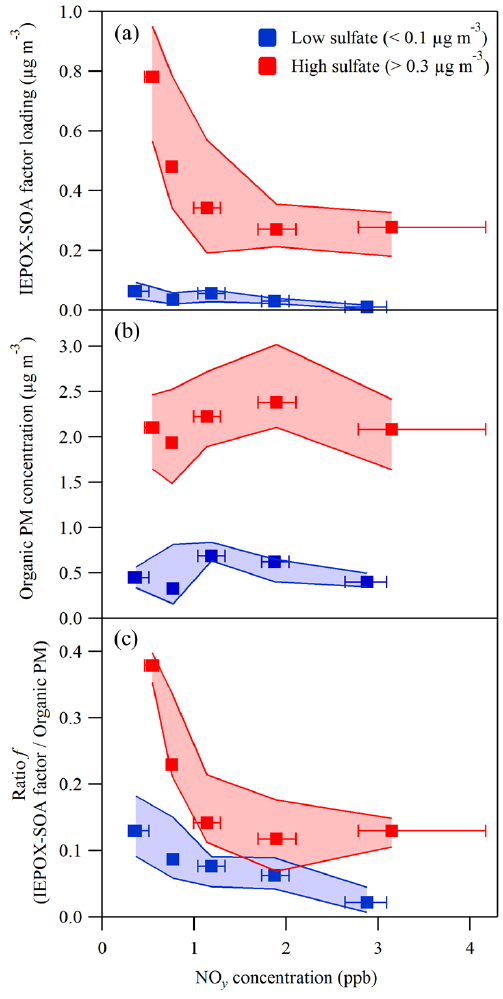
Figure 7. Dependence on NO y concentration of (a) IEPOX-SOA factor loading, (b) organic mass concentration, and (c) the ratio f of the IEPOX-SOA factor loading to the organic PM concentration. Data are segregated by low ( < 0.1µgm − 3 ) and high ( > 0.3µgm − 3 ) sulfate mass concentration and grouped into five levels of NO y con- centration (Fig. 6). Squares represent medians of each group. In- terquartile ranges are represented by whiskers along the abscissa and shading along the ordinate. The plotted data sets were recorded during local afternoon (12:00–16:00 local time;